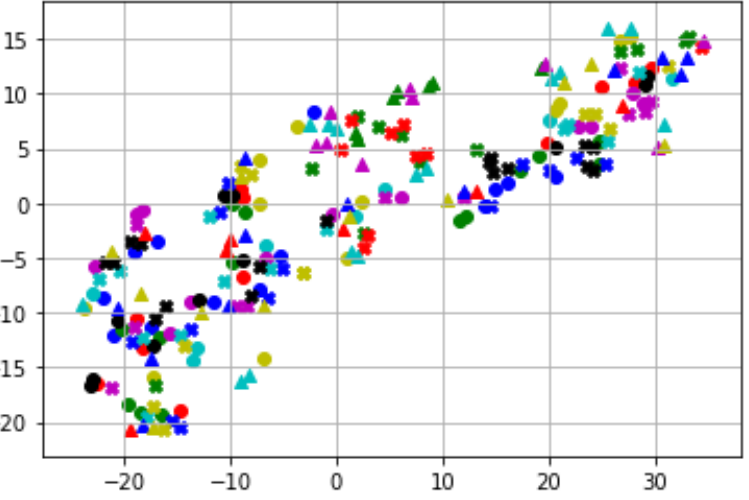
Figure 19. t-SNE feature maps of CASIA-A. A different color and shape marker indicates a feature.